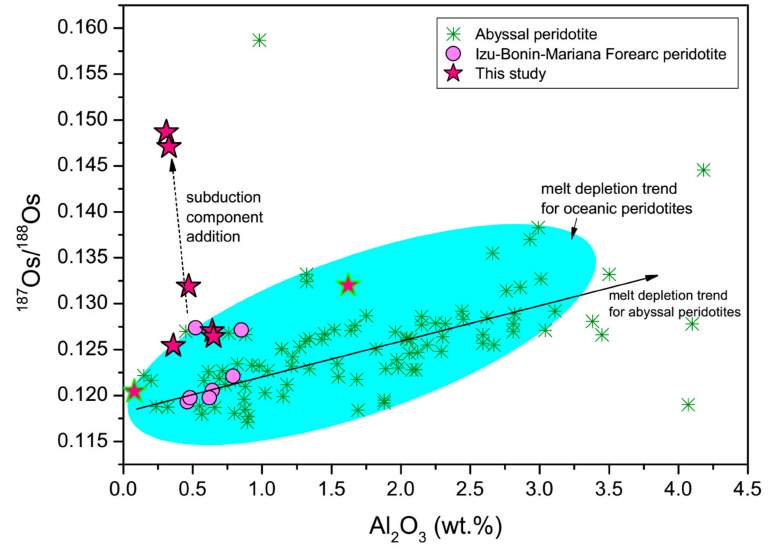
Figure 5. Plot of 187 Os / 188 Os versus Al 2 O 3 content of the Yap Trench peridotites. Data sources are the same as in Figure 4. Samples from the southern Yap Trench are shown by stars with green border. The cyan field shows the general trend of typical oceanic peridotites. Solid arrows show the melt depletion trends for abyssal peridotites. Dashed arrows show the subduction component addition trend for the Yap Trench